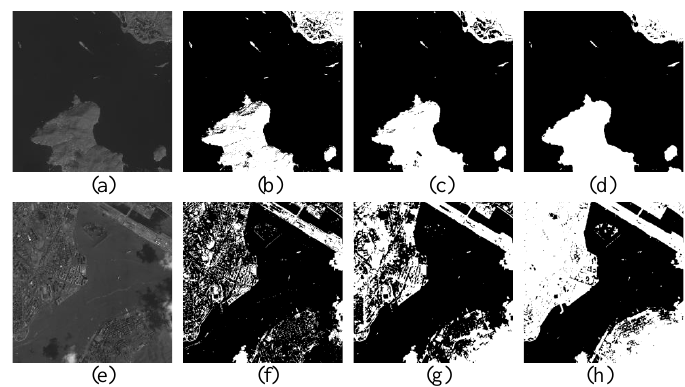
Figure 11. Sea-land segmentation comparison between Otsu and NDWI. ( a , e ) denote the original panchromatic images; ( b , f ) are the results of Otsu on panchromatic images; ( c , g ) are the results of Otsu on NIR images; ( d , h ) are the results of NDWI based on NIR and green